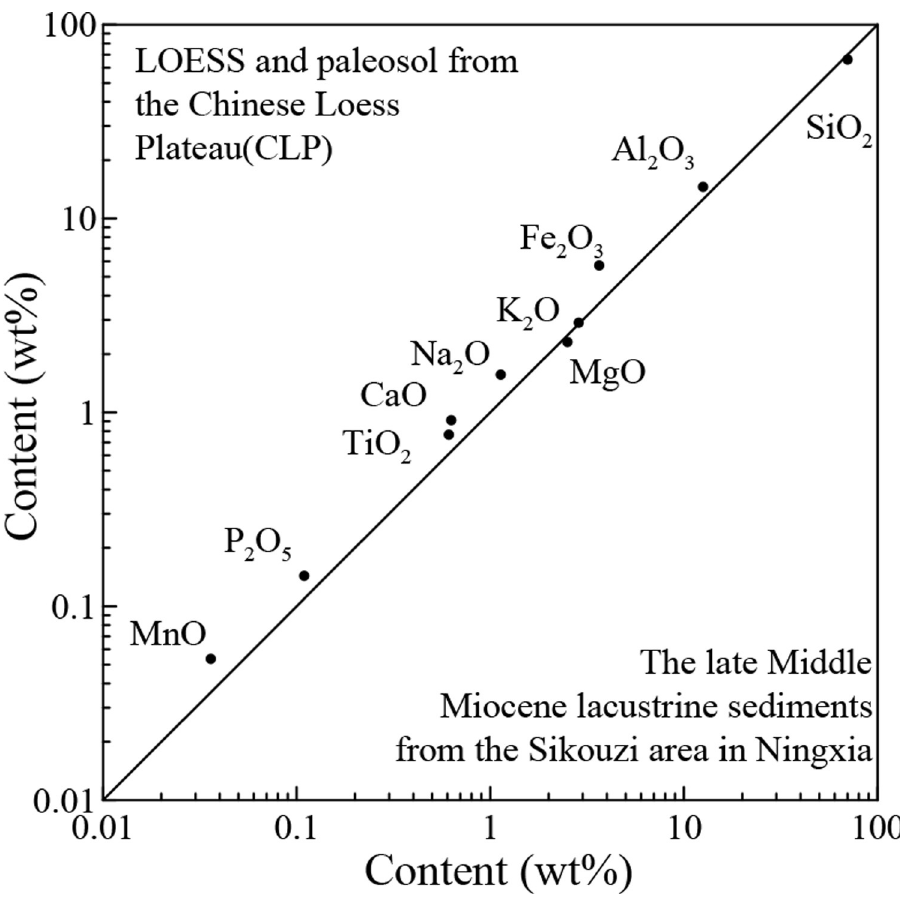
Fig 3. Comparison diagram of major element compositions between the Sikouzi fluviolacustrine fine samples in this study and the loess-soil samples at Baishui in the CLP [28].